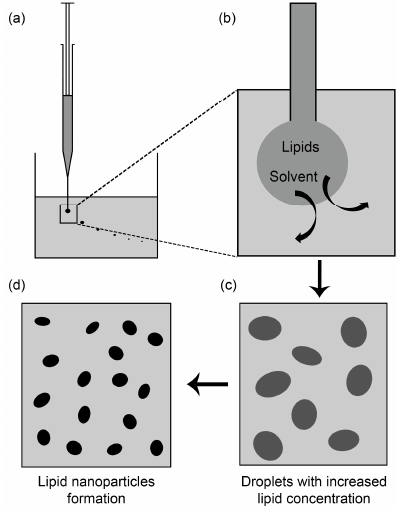
Figure 1. Schematic representation of lipid-nanoparticle formation using the solvent injection method. Lipids and drugs are dissolved in a water-miscible solvent (organic phase) and injected into an aqueous phase containing emulsifiers ( a ). Following injection, the solvent gradually di ff uses into the aqueous phase ( b ), which leads to droplet division and a reduction in droplet size while lipid concentration is increased ( c ). Consequently, solid lipid nanoparticles and nanostructured lipid carriers are formed and stabilized by the emulsifiers ( d